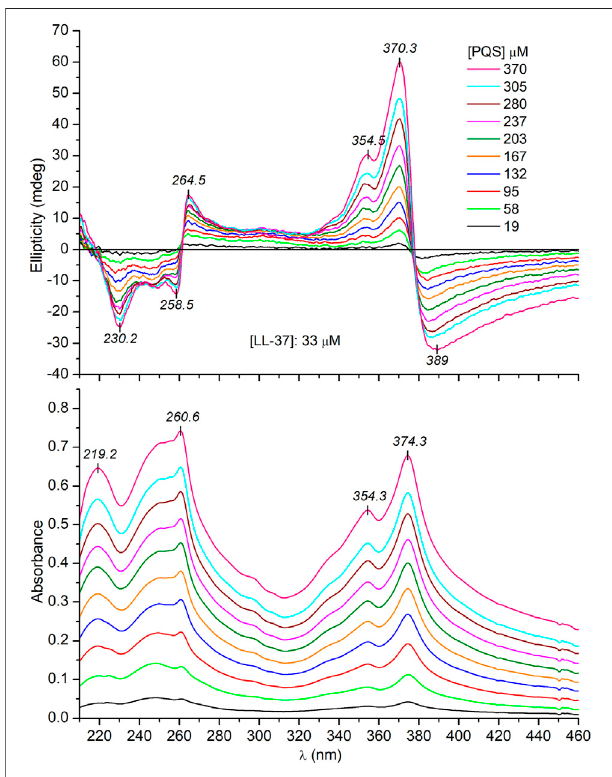
FIGURE 4 | Representative CD and UV/VIS absorption spectra recorded upon a consecutive increase of PQS concentration in PBS solution of 33 μ M LL-37 (the optical path length is 0.2